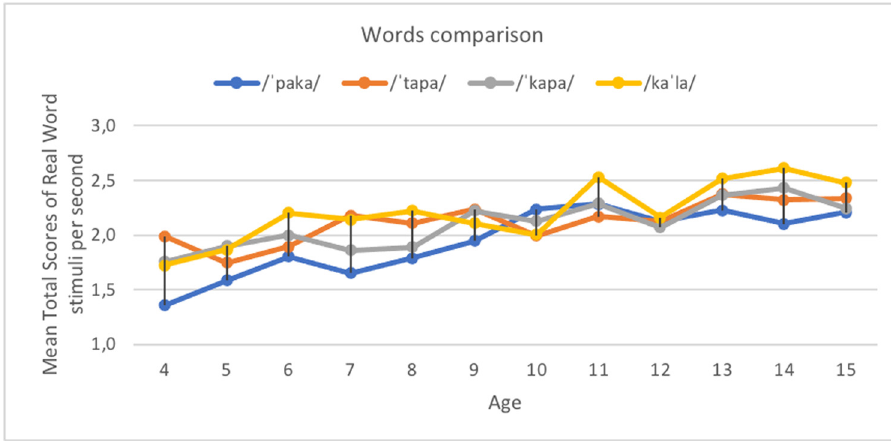
Figure 2: Real word stimuli repetition per second by